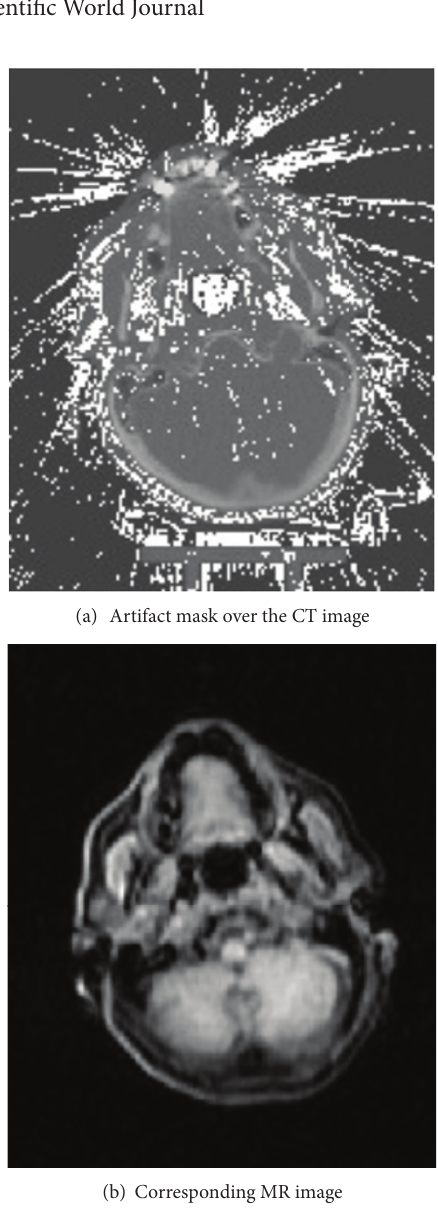
Figure3:DetectedartifactsonCTimage(a)andcorrespondingMR image (b).